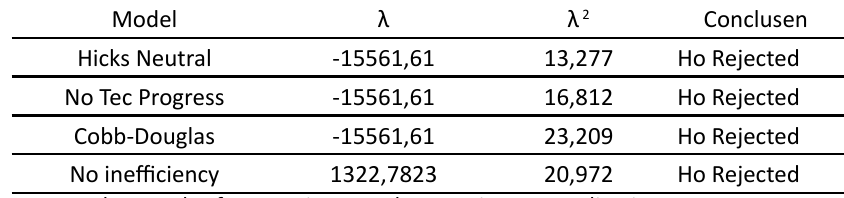
Table 2: Estimation Result of Translog Stochastic Frontier Production Function and Translog’s Sub Models